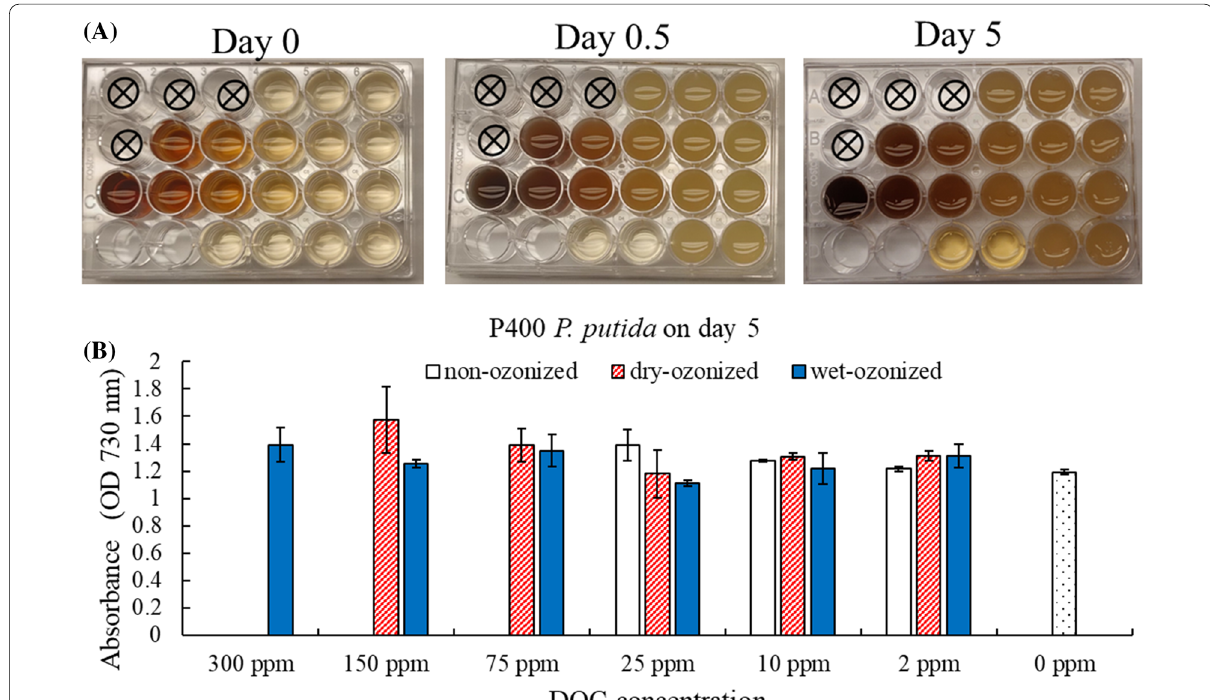
Fig. 2 Growth assay of P. putida in incubation with filtrates from wet-ozonized, dry-ozonized, and non-ozonized pine 400 biochar at different DOC concentrations. A Photographs of multi-well plate with P400 biochar filtrates inoculated with P. putida on day 0, day 0.5 and day 5 of the growth assay. The photographs shown are one of the two replicates. The setup of the plate is shown in Table 1. B Optical density (OD730) of P. putida liquid culture after 5 days of incubation with P400 biochar filtrates. The error bars on the graph represent the standard deviation of the 2 multi-well plates ( n =